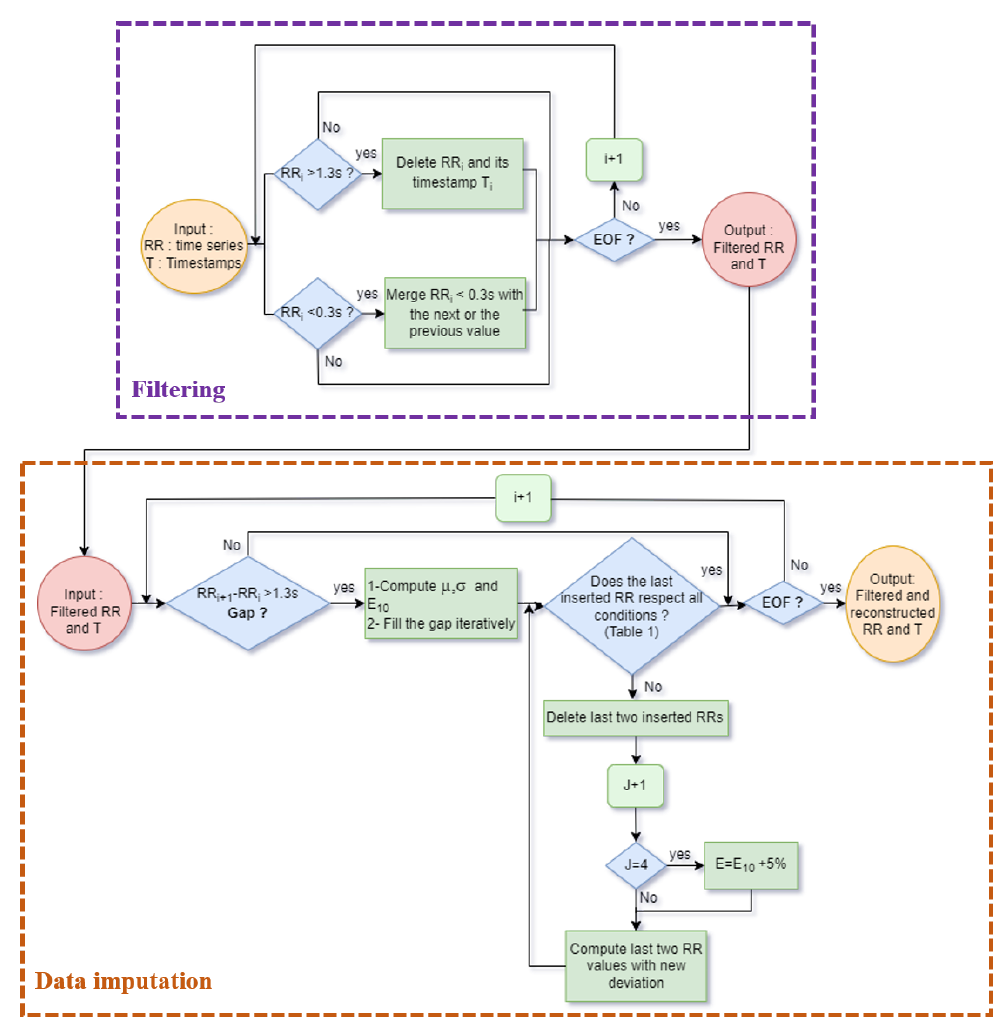
Figure 2. Flowchart for DVC algorithm including filtering and data imputation